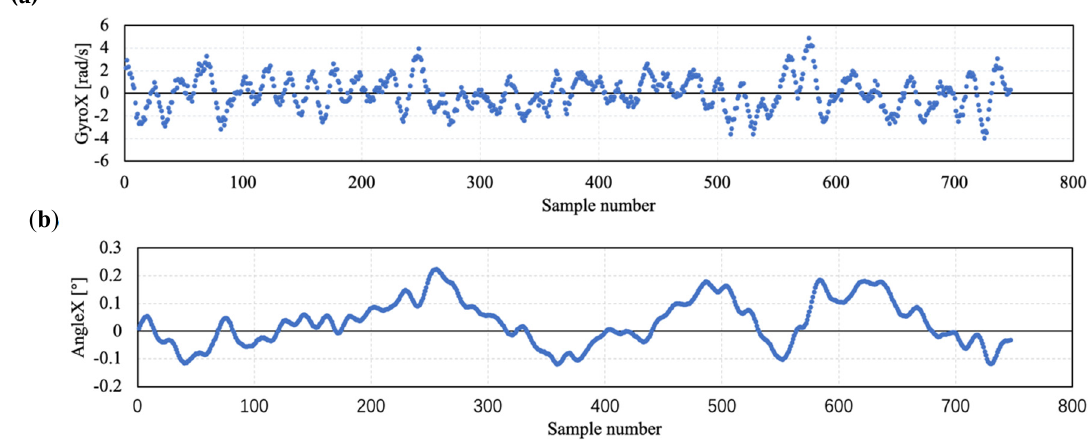
Figure 5. Measured and calculated sensor signals. ( a ) The measured angular velocity signal around X-axis, ( b ) the calculated angle signal around X ‐ axis.